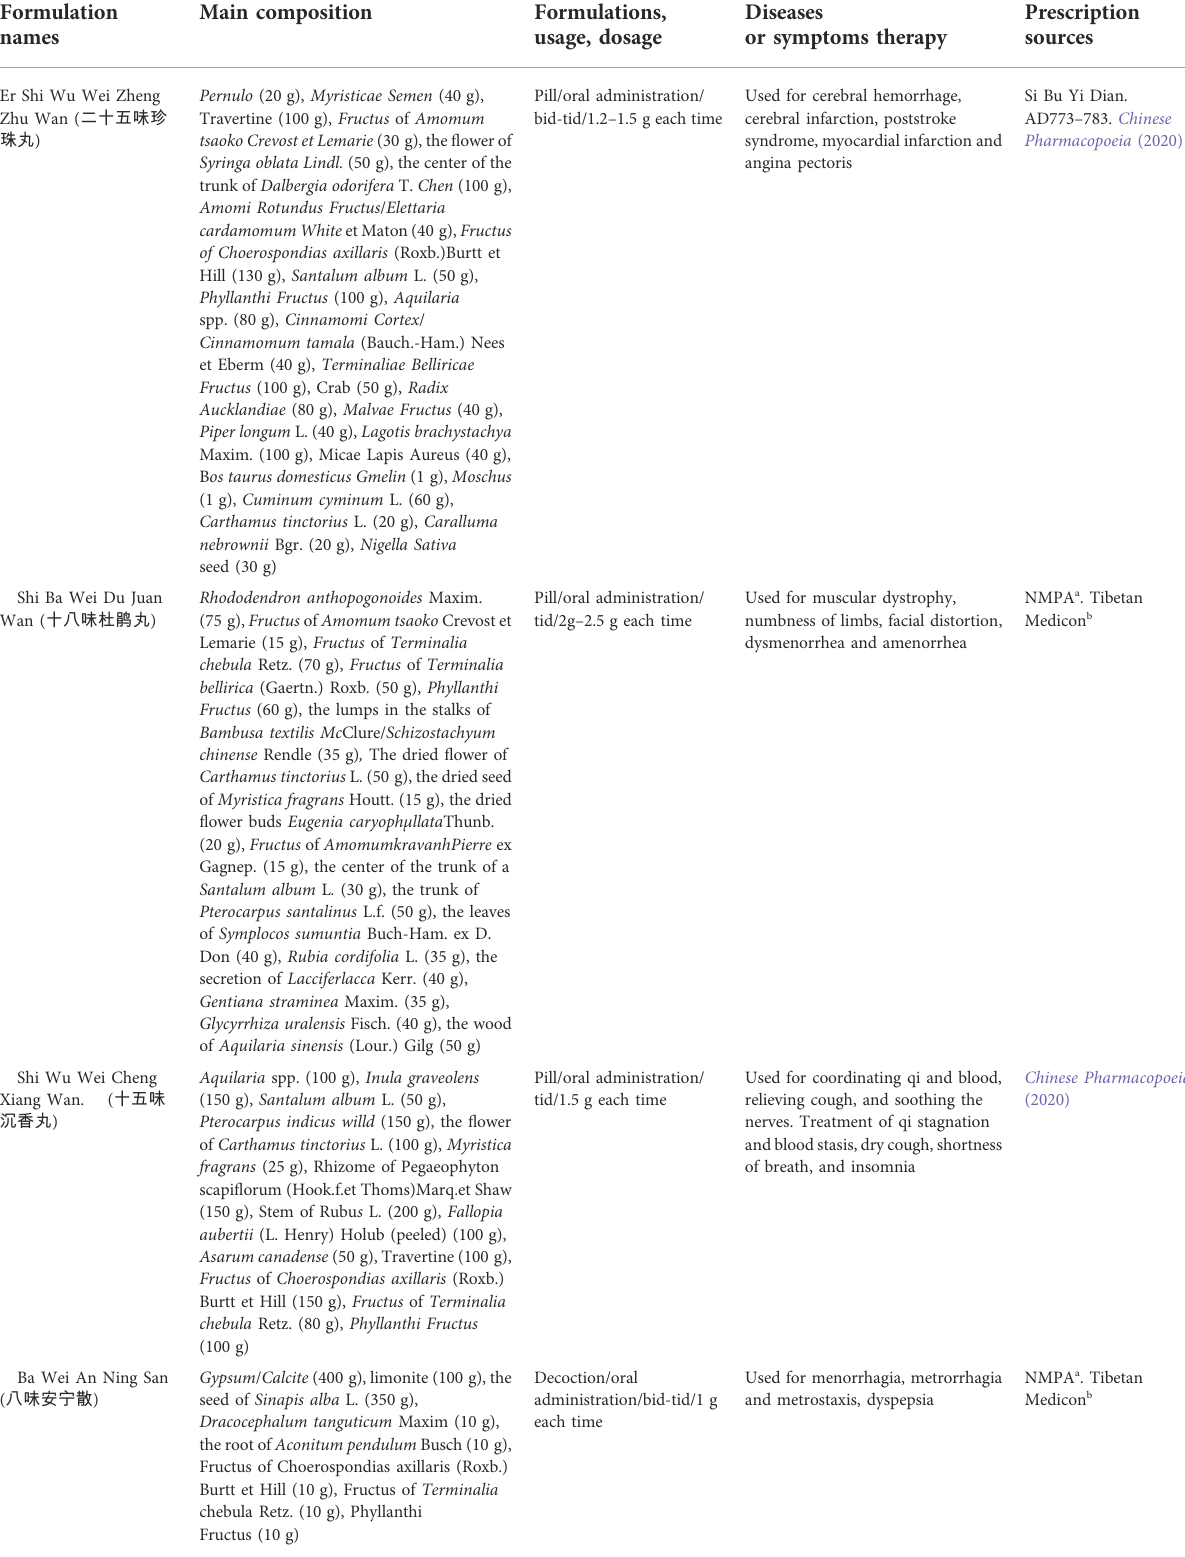
TABLE 5 Traditional Chinese formulations containing